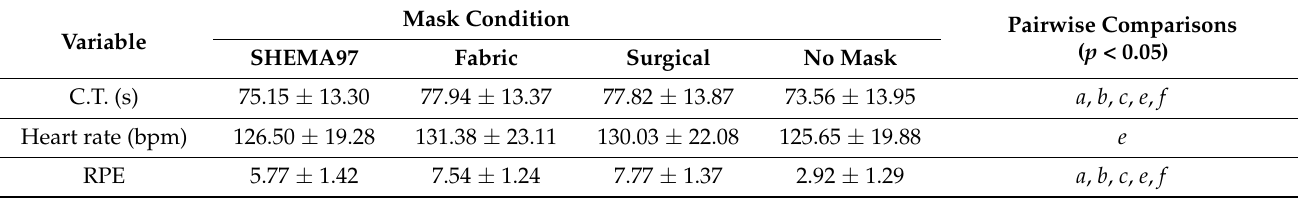
Table 2. Performance variables based upon mask